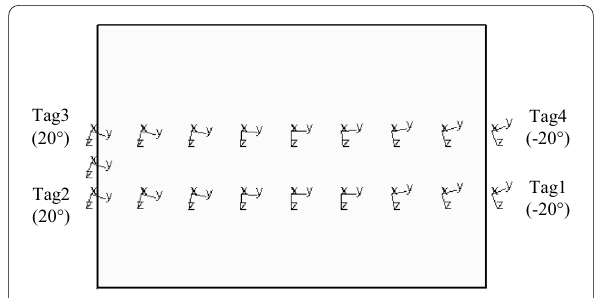
Figure 25 Smoothing results of interpolation positions